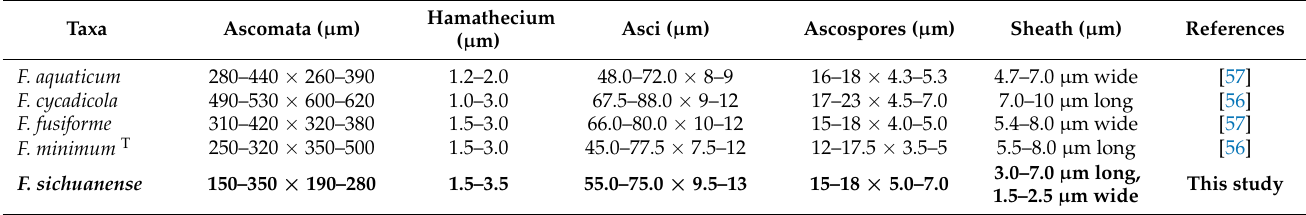
Table 3. Morphological comparative data of Flabellascoma